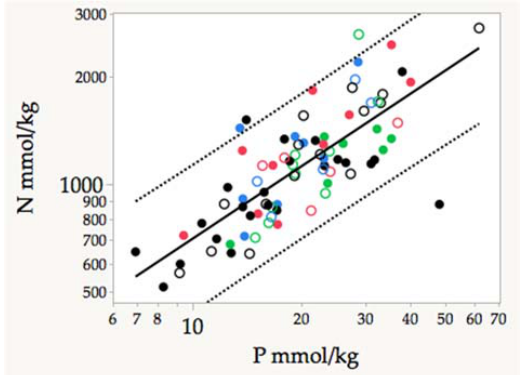
Figure 4. Correlation between N and P concentrations in adult leaves from different karst forest species. Guánica forests: dwarf, Black; ridge, empty black; Guajataca, solid blue; Cambalache, empty blue; Tallonal solid green; Nevarez, empty green; Río Lajas, solid red; Hato Tejas, empty red. Log (N mmol/kg) = 5.011 + 0.672 × Log (P); Fratio = 120; F < p < 0.001; R 2 adj = 0.592; n = 83.